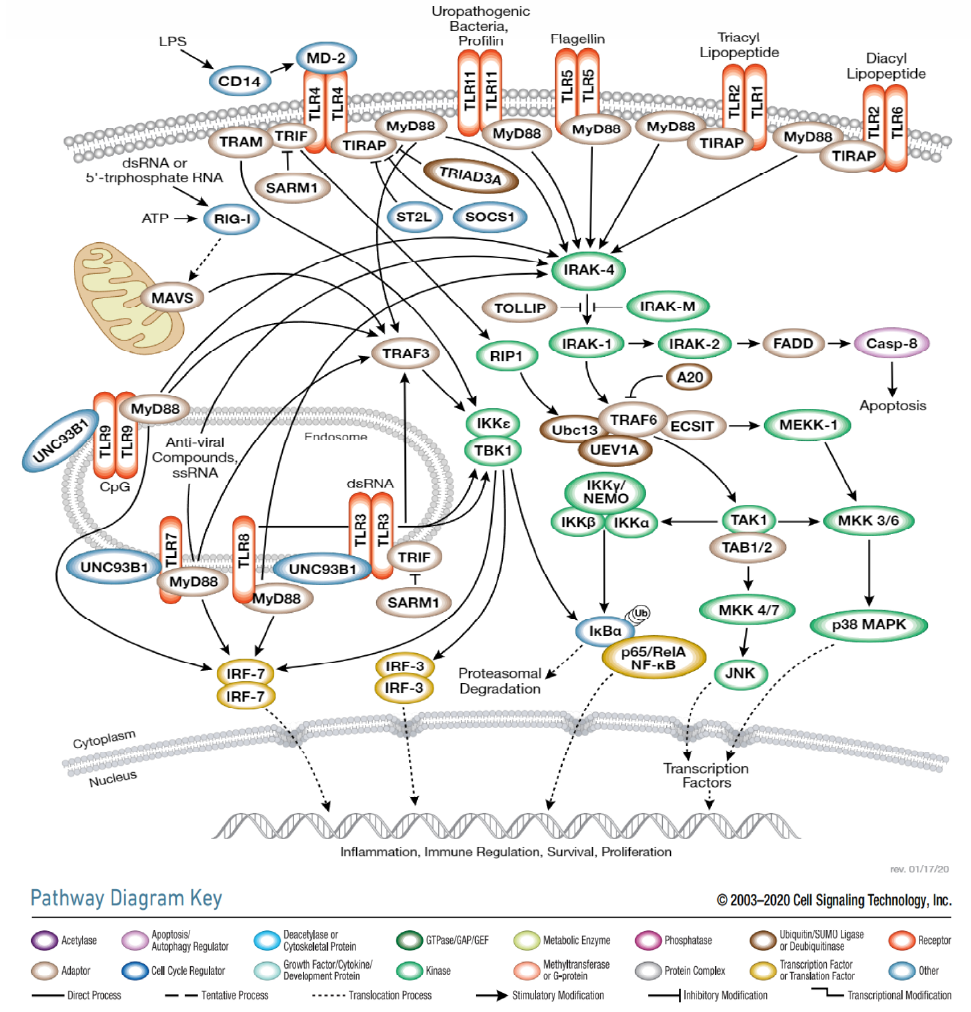
Figure 2. Toll-like Receptor (TLR) signaling. Illustration reproduced courtesy of Cell Signaling Technology, Inc, Danvers, Massachusetts, USA. (www.cellsignal.com accessed on 6 October 2021. Technology, Inc., Danvers, MA, USA. (www.cellsignal.com accessed on 6 October